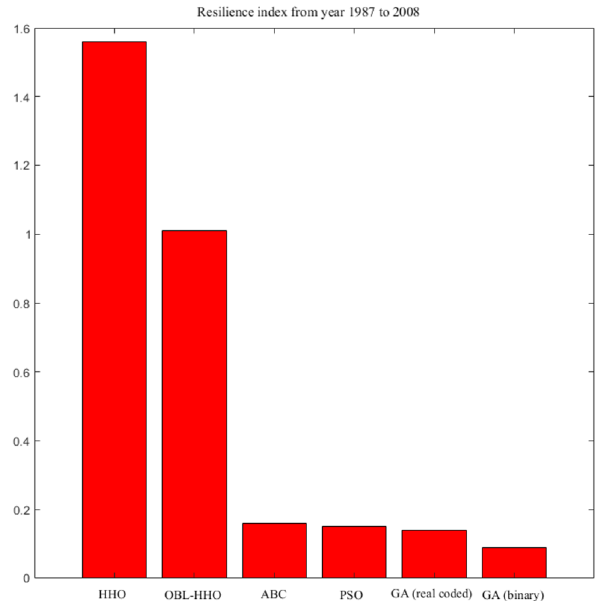
Figure 10. Resilience index from year 1987 to